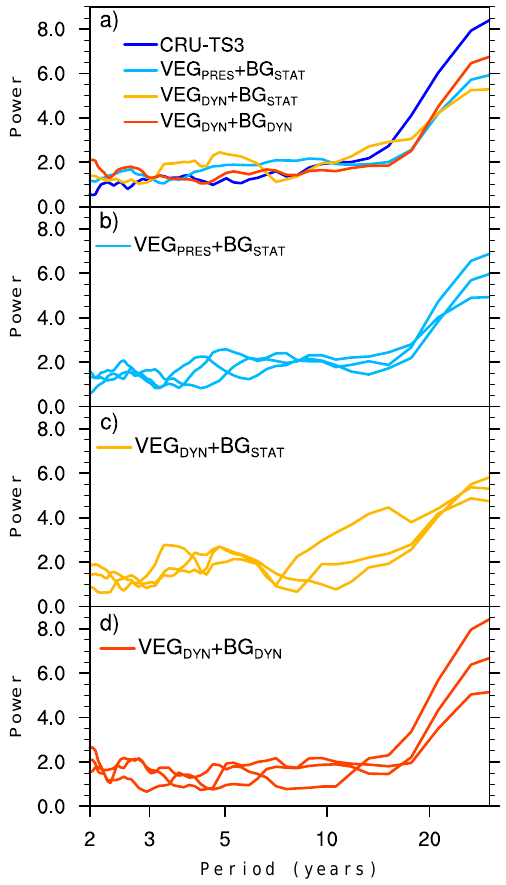
Fig. 5. Power spectra of normalised precipitation for the years 1901–2006. (a) Observed precipitation, CRU-TS3 (Mitchell and Jones, 2005) (dark blue), and the mean spectra of the en- semble member spectra of each setup (VEG PRES + BG STAT , VEG DYN + BG STAT , VEG DYN + BG DYN ). Power spectra of in- dividual ensemble members for the (b) VEG PRES + BG STAT , (c) VEG DYN + BG STAT and (d) VEG DYN + BG DYN simulations.